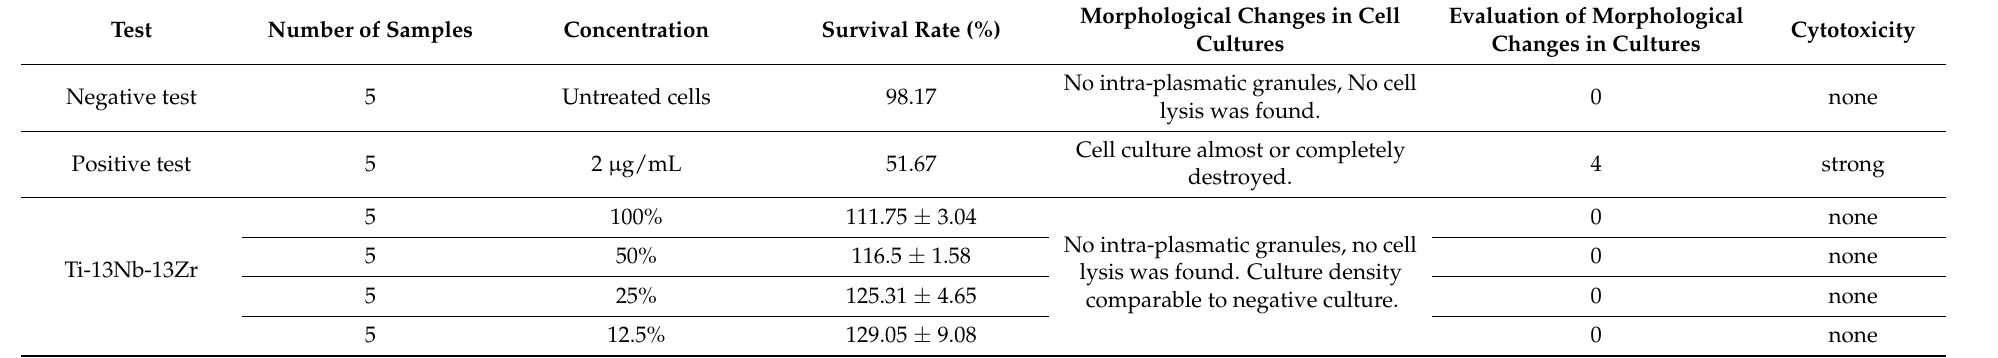
Table 7. MTT test result for NHDF